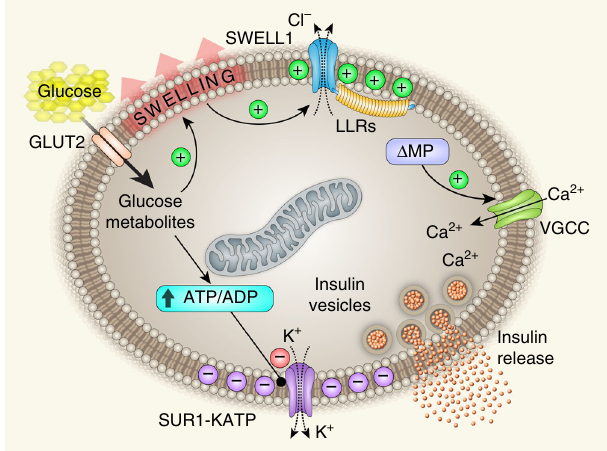
Fig. 9 Working model: SWELL1 is a virtual glucose sensor regulating β -cell excitability and systemic glycaemia. GLUT2, glucose transporter; Δ MP, membrane depolarization; VGCC, voltage-gated